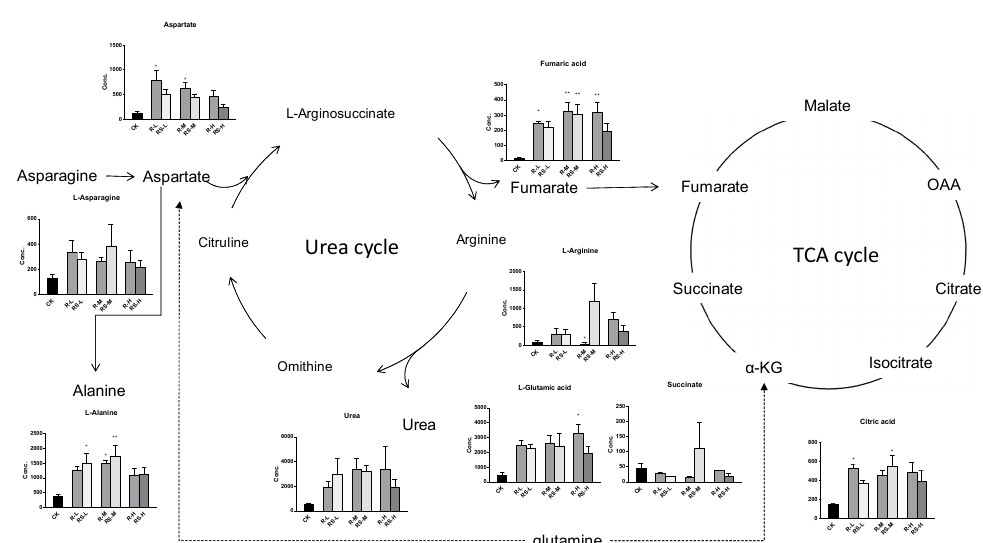
Figure 5. Disturbance of the urea and tricarboxylic acid (TCA) cycle metabolic pathway after metalaxyl and metalaxyl-M treatment.